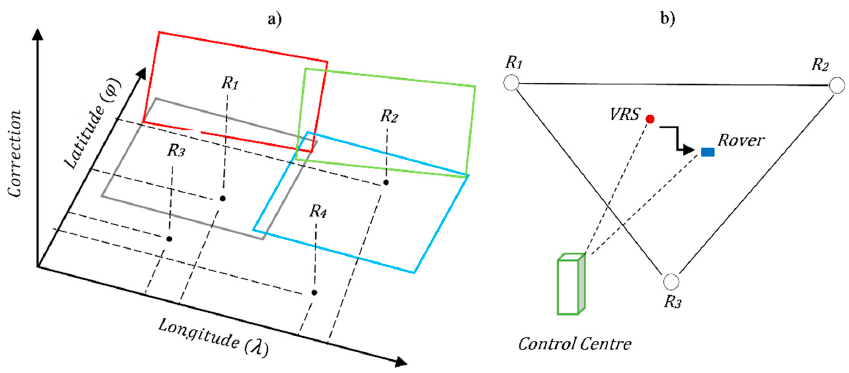
Figure 1. ( a ) FKP method, ( b ) VRS method.